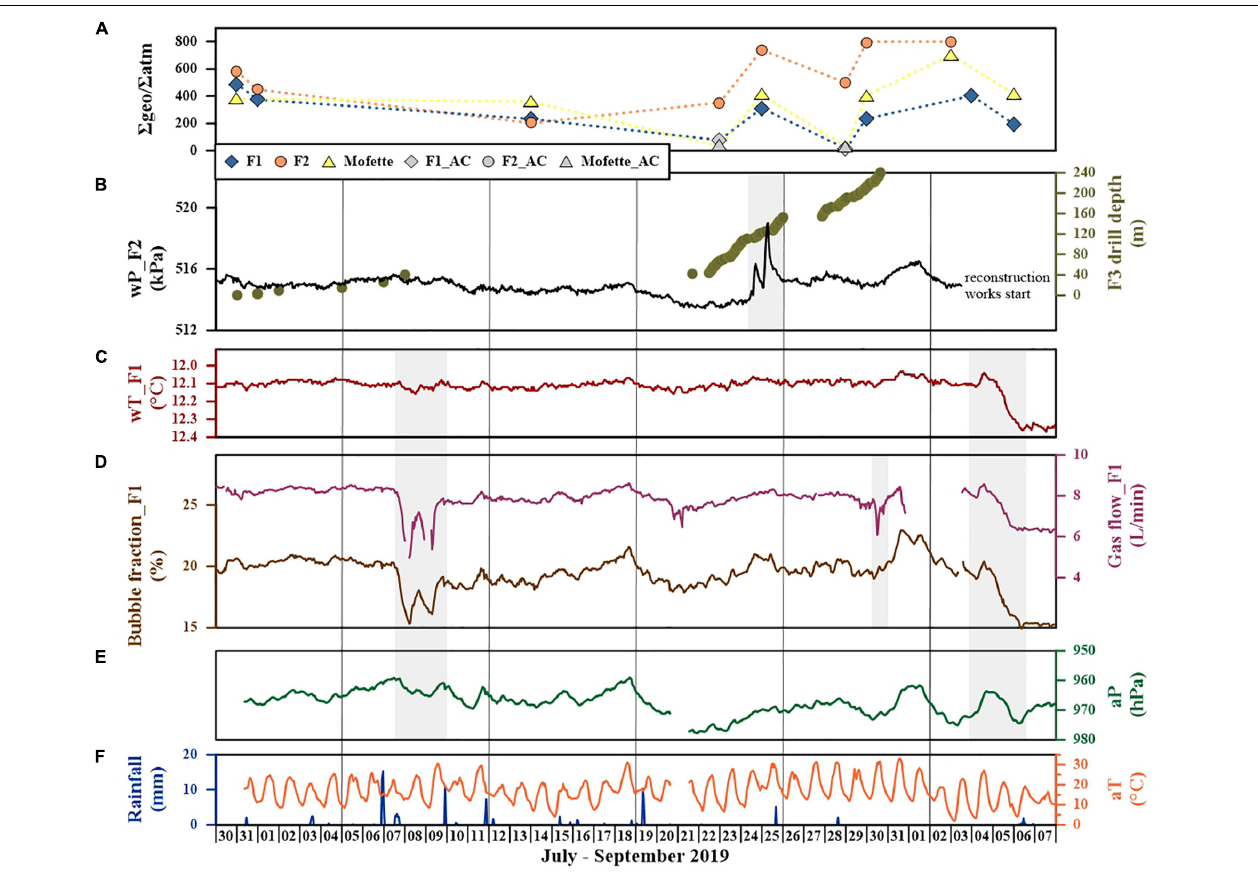
FIGURE 4 | Time series plot for the period 30th of July-7th of September 2019 showing (A) (cid:54) geo/ (cid:54) atm ratio in the two boreholes and the mofette, where (cid:54) geo = CO 2 +He+H 2 +C x H y and (cid:54) atm = N 2 +O 2 +Ar, (B) the wellhead pressure (wP) of F2 and the drilling depth of F3 (Woith et al., 2020), (C) the water temperature (wT) in F1, (D) the calculated bubble fraction and the measured gas flow in F1, (E) the barometric pressure (aP) and (F) the meteorological conditions represented by the precipitation and the air temperature (aT). The axes of water temperature and barometric pressure are inverted. The vertical gray lines indicate the beginning of a new week, while the gray areas correspond to anomalies discussed in the text. Data of the gas flow and the temperature monitoring at Hartoušov are available at web.natur.cuni.cz/uhigug/carbonnet/en_index.html.